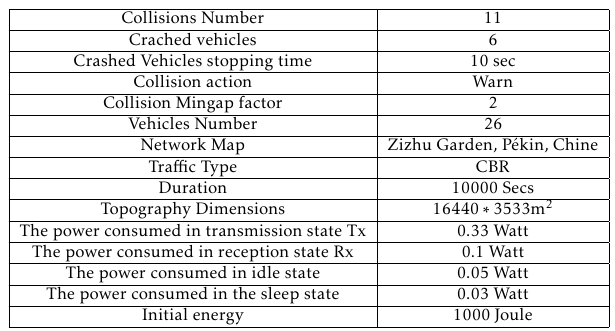
Table 3. VANets with Collision Simulation